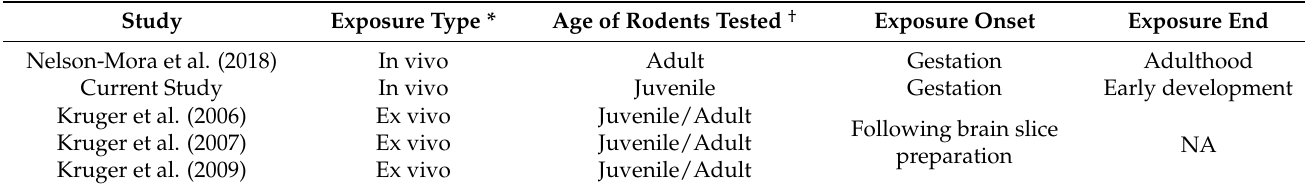
Table 1. Timeline of arsenic exposure in current and previous electrophysiology studies.